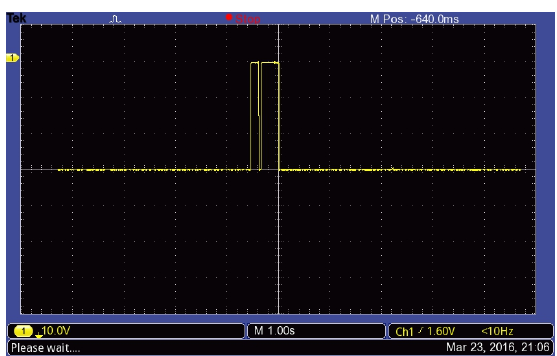
Figure 17. Voltage waveform obtained by interpreting optical Morse code “1”.